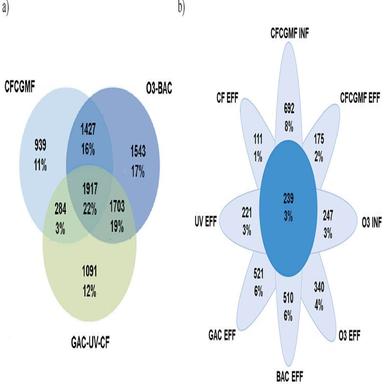
Venn Diagram showing unique and shared operational taxonomic units (OTUs) detected at a) main barrier level Coagulation/Flocculation/Clarification/ Granular Media Filtration (CFCGMF), Ozonation-Biological Activated Carbon Filter (O3-BAC), and Granular Activated Carbon Filter, UV Disinfection, and Cartridge Filtration (GAC-UV-CF) and b) each treatment: CFCGMF influent and effluent, ozone effluent (O3 EFF), BAC filter effluent (BAC EFF), GAC filter effluent (GAC EFF), UV irradiation effluent (UV EFF), and car